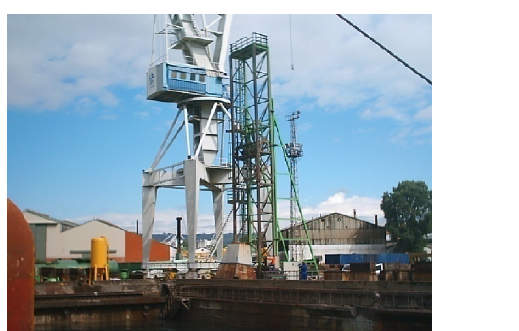
Figure 4. Primary Structure Vertical